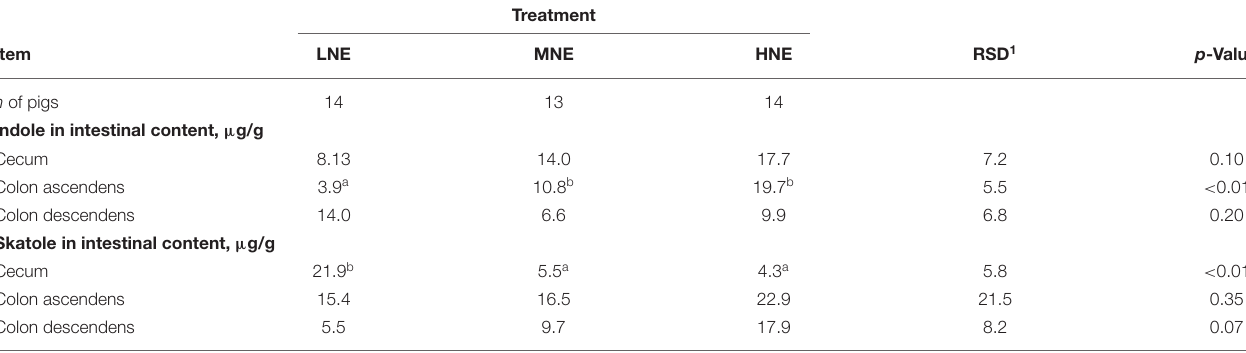
TABLE 6 | Effect of changes in dietary net energy concentration on intestinal skatole and indole production.